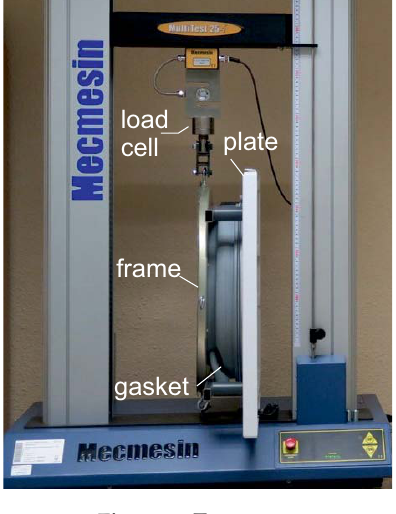
Figure 5. Test setup.